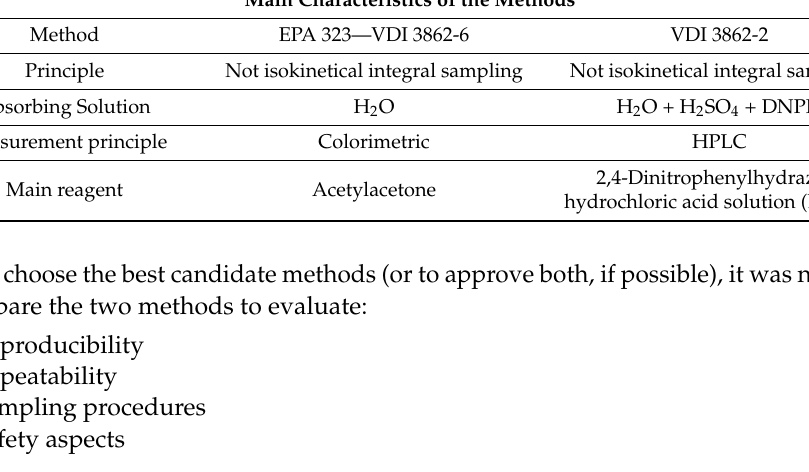
Table 1. Characteristics of the method EPA 323—VDI 3862-6 and method VDI 3862-2. Main Characteristics of the Methods Method EPA 323—VDI 3862-6